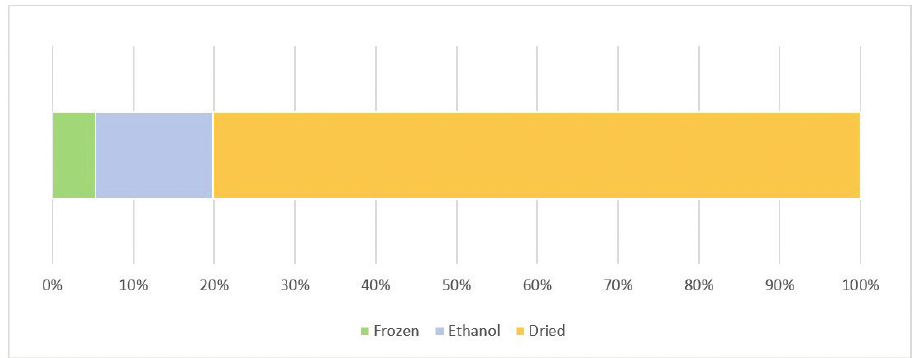
Figure 6. Number of individuals by preservation method stored at MNA. Dried specimens percentage in orange (~80%), ethanol in blue (~15%), and frozen in green